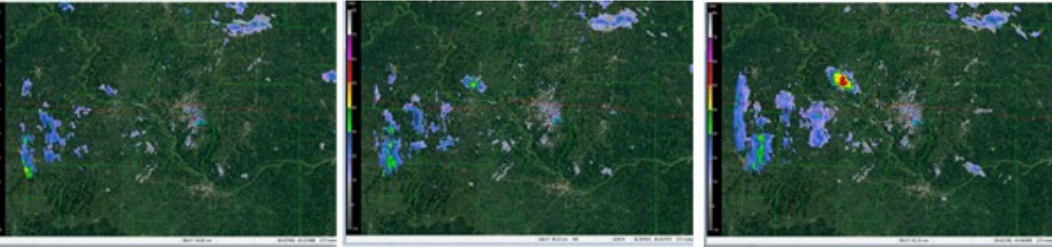
Figure 6. Sequence of RADAR reflectivity images from 18 September 2015 obtained from the MZZU RADAR at 1510 UTC ( left ), 1516 UTC ( center ) and 1521 UTC ( right ) showing the rapid development of an isolated convective storm.